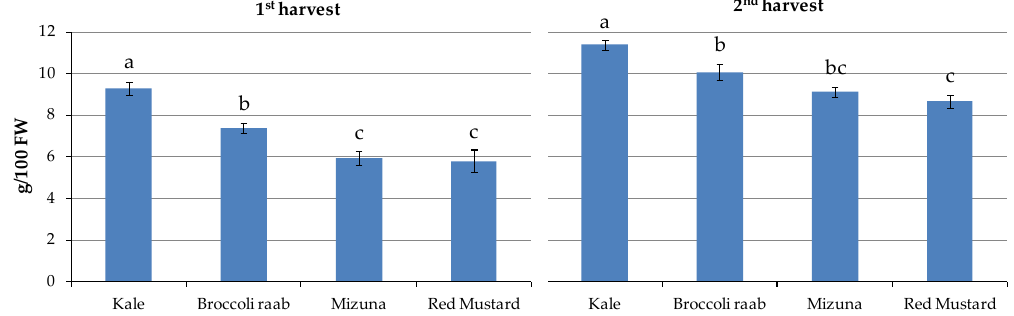
Figure 3. Effect of genotypes on DM measured at 1st and 2nd harvest ( p ≤ 0.001). Different letters indicate that mean values are significantly different at α = 0.05 by LSD test.